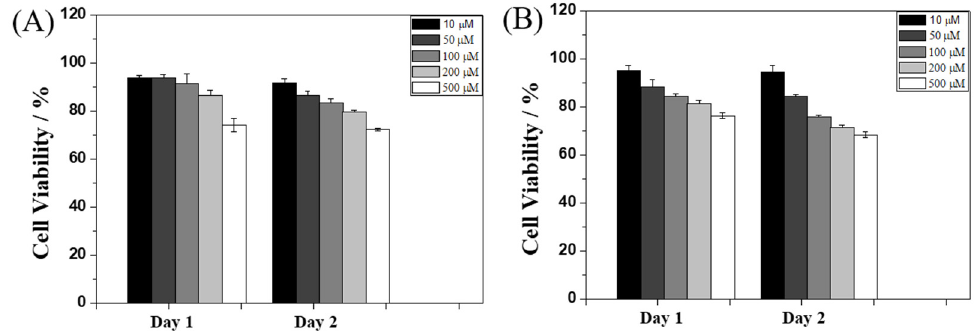
Figure 6. Viability ratio measured using MTT assay on hMSCs in the presence of 10, 50, 100, 200, and 500 μ M of ( A ) Ben-IKVAV and ( B ) PFB-IKVAV for 48 h.